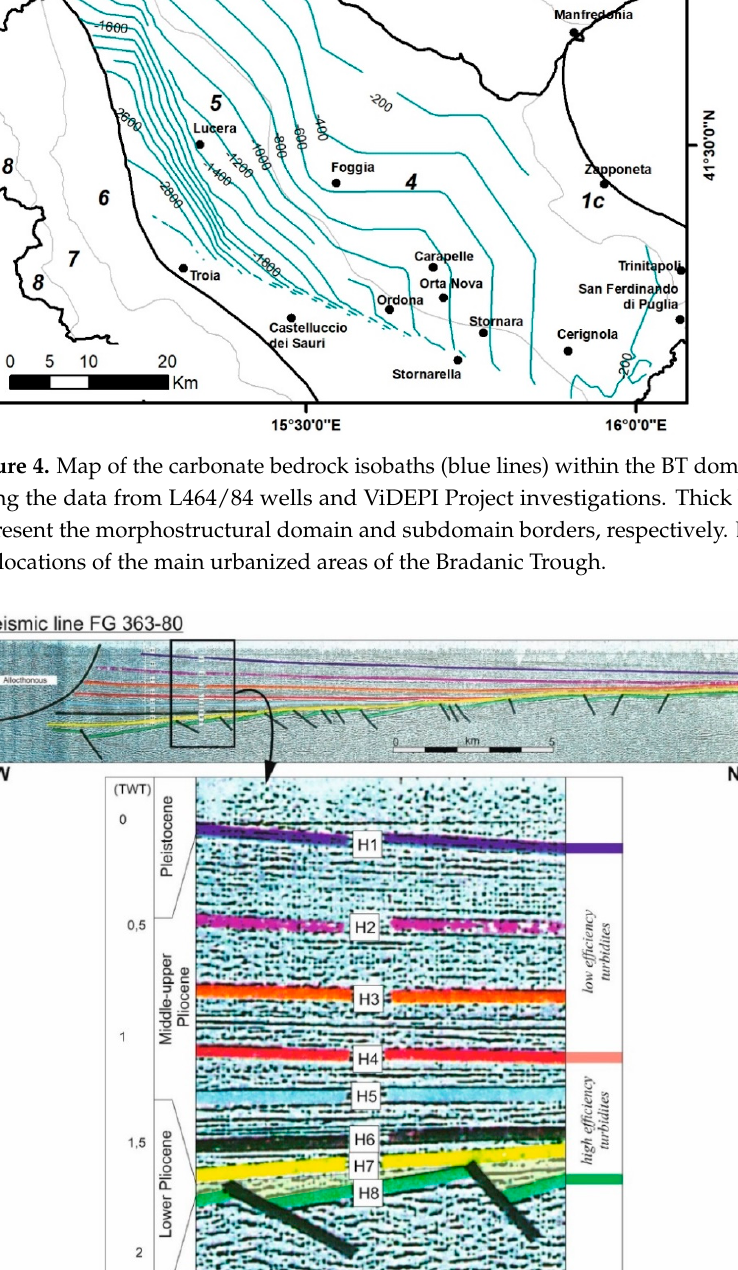
Figure 5. Line drawing and interpretation of FG 363–80 ViDEPI seismic reflection line (modified from [27]). The location is shown in Figure 3A. Colored lines represent the identified seismic hori- zons; thick black lines correspond to the recognized tectonic structure. TWT indicates the two-way travel time values.